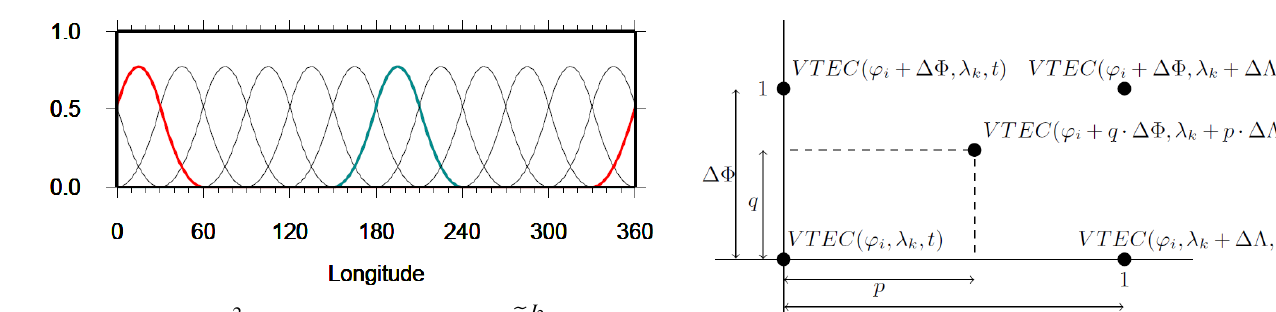
(λ) , accord- k 2 (λ) with Figure 4. Schematic representation of the four-point spatial interpo- 5 lation to calculate the VTEC value at P(ϕ i + q · (cid:49)(cid:56),λ k + p · (cid:49)(cid:51)) (λ) shows from the four corner points of the grid cell of 11